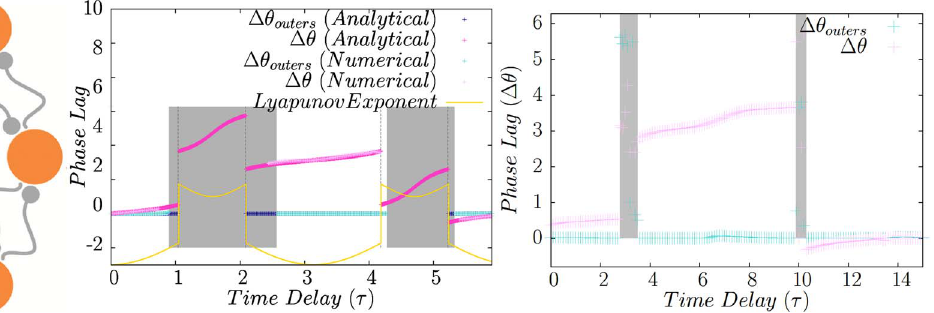
Fig. 5. Homogeneous relay system. In a homogeneous relay system, synchronized state of outer neurons is not stable for all the values of the delay time. Dark blue and cyan points show the phase difference of outer neurons in stable regions resulted from analytic calculations and direct numerical integration, respectively. Dark pink (pink) points show analytical (numerical) results for the phase difference of the outer neurons with the relay neuron. Yellow and orange lines show the characteristic exponent of the map which is negative in case of stability of synchrony. Vertical dashed lines show the boundary of stability domains (characterized by negative exponents) and shaded area indicates the domain over which numerical integration shows no synchrony. In the right panel numerical results are presented for the relay system with Hodgkin-Huxley neurons. It is notable that although the same pattern of synchronization regions is seen, but the domain over which the synchrony is unstable is quite narrower for the relay system with HH neurons.